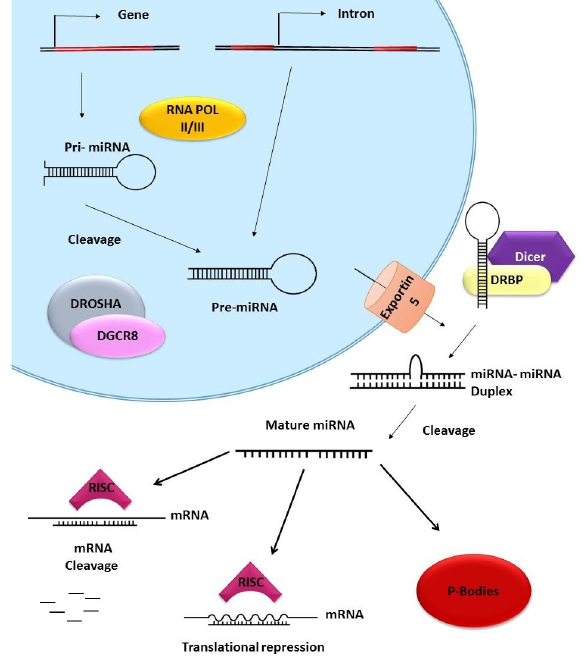
Figure 1. microRNAs